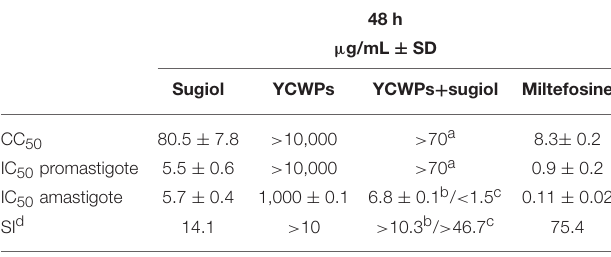
TABLE 1 | Antileishmanial activity (IC 50 ) and cytotoxicity (CC 50 ) from empty YCWPs and YCWPs +